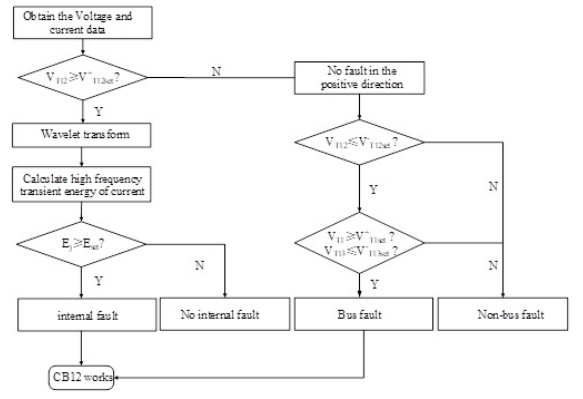
Fig. 8. Schematic diagram of protection action